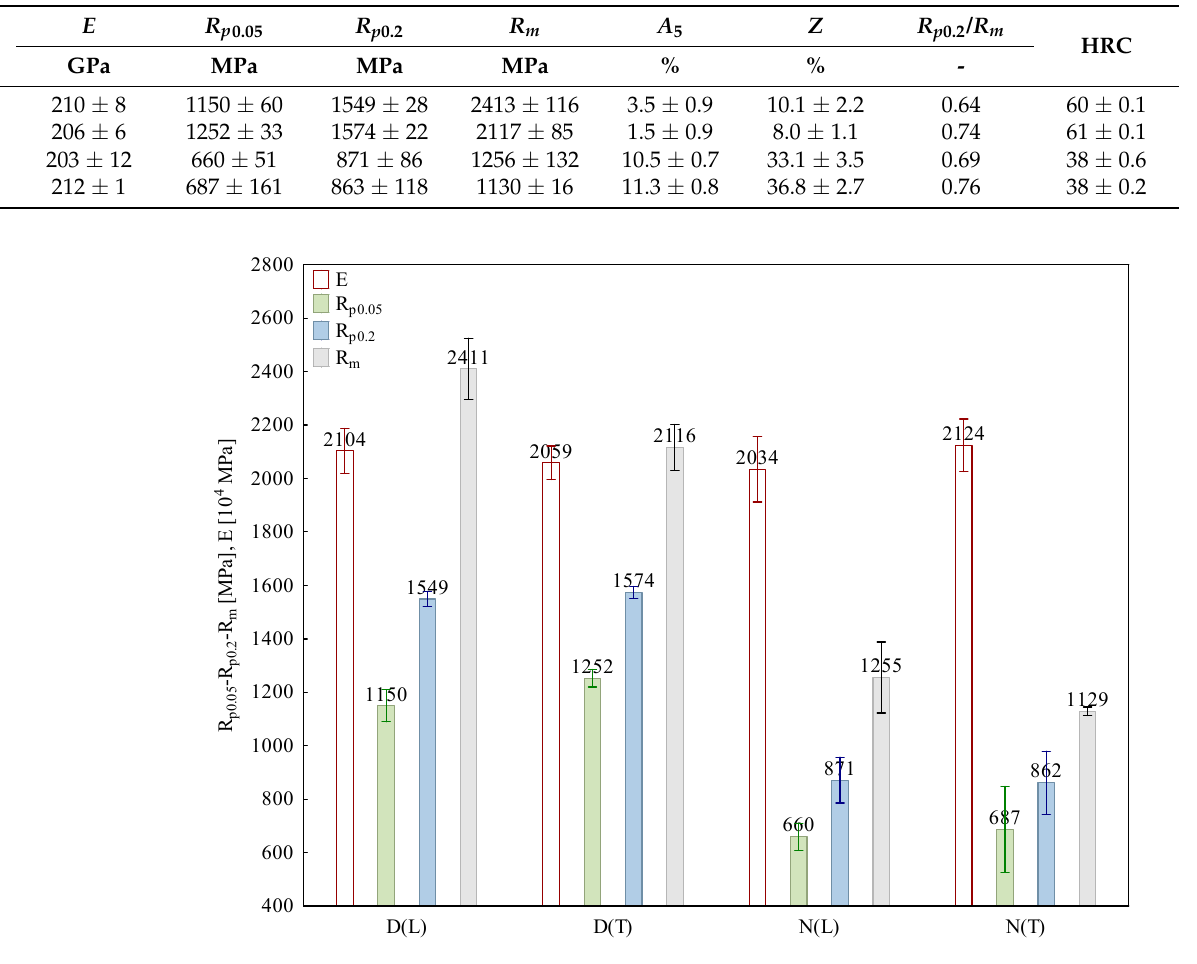
Figure 6. Tensile strength ( R m ), yield strength ( R p 0.2 ), elastic limit ( R p 0.05 ) and Young’s modulus ( E ) of Hardox Extreme steel in delivery and normalized states.